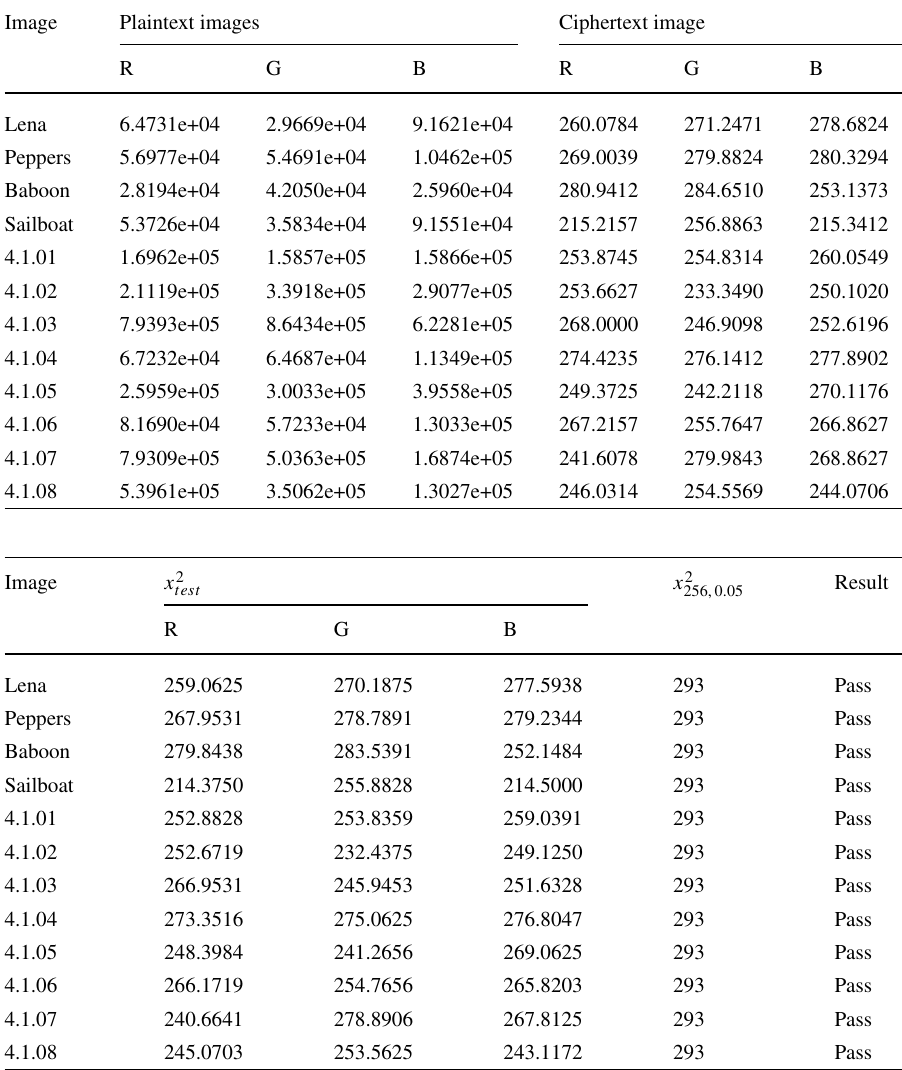
Table 4 Histogram variance of plaintext and ciphertext images Image Plaintext images Ciphertext image